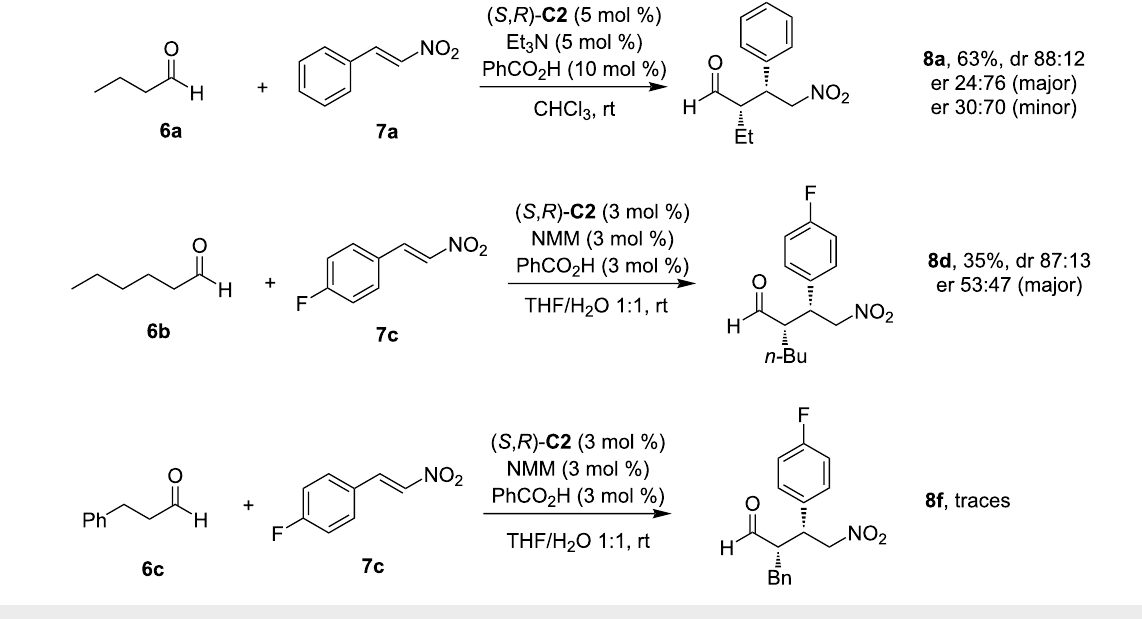
(Table 1, entry 1). Using chloroform/isopropyl alcohol 9:1